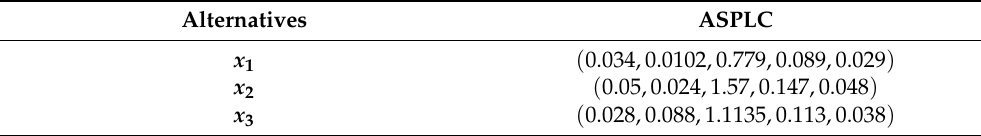
Table 6. ASPLC aggregation results.